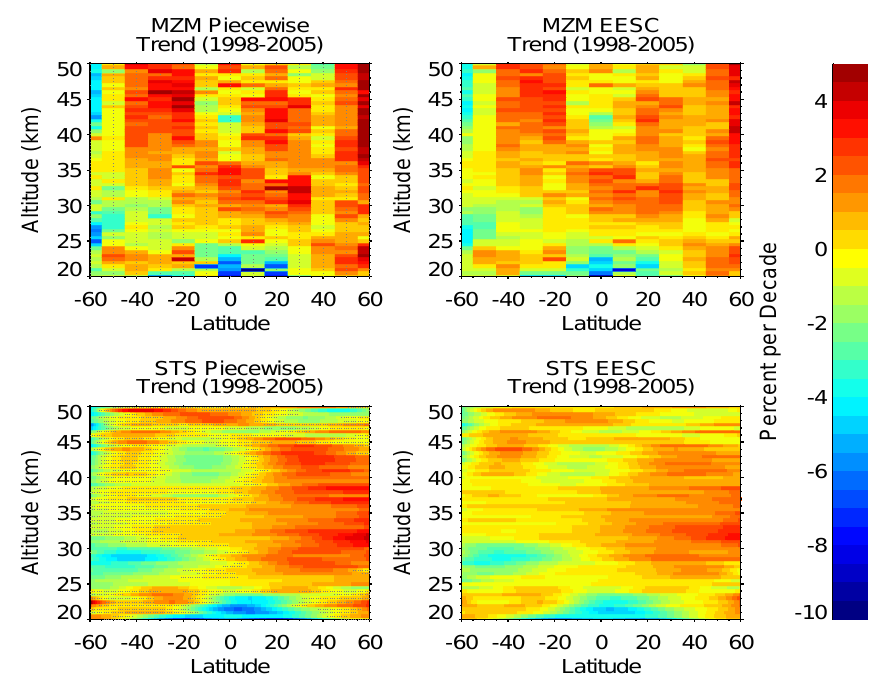
Figure 15. Mean trend between 1998 and 2005 for four analysis scenarios computed as (Tr(2005) − Tr(1998)) / Tr(1998) · 100, where Tr( t ) represents the value of the long-term trend term at time t . The analysis was run for both the MZM and STS regression methods, each using either a piecewise linear term joined at 1997.0 or two orthogonal EESC terms. Stippling shows regions where the linear slope is not significant at the 2 σ level. No similar calculation can be done for multiple EESC terms.